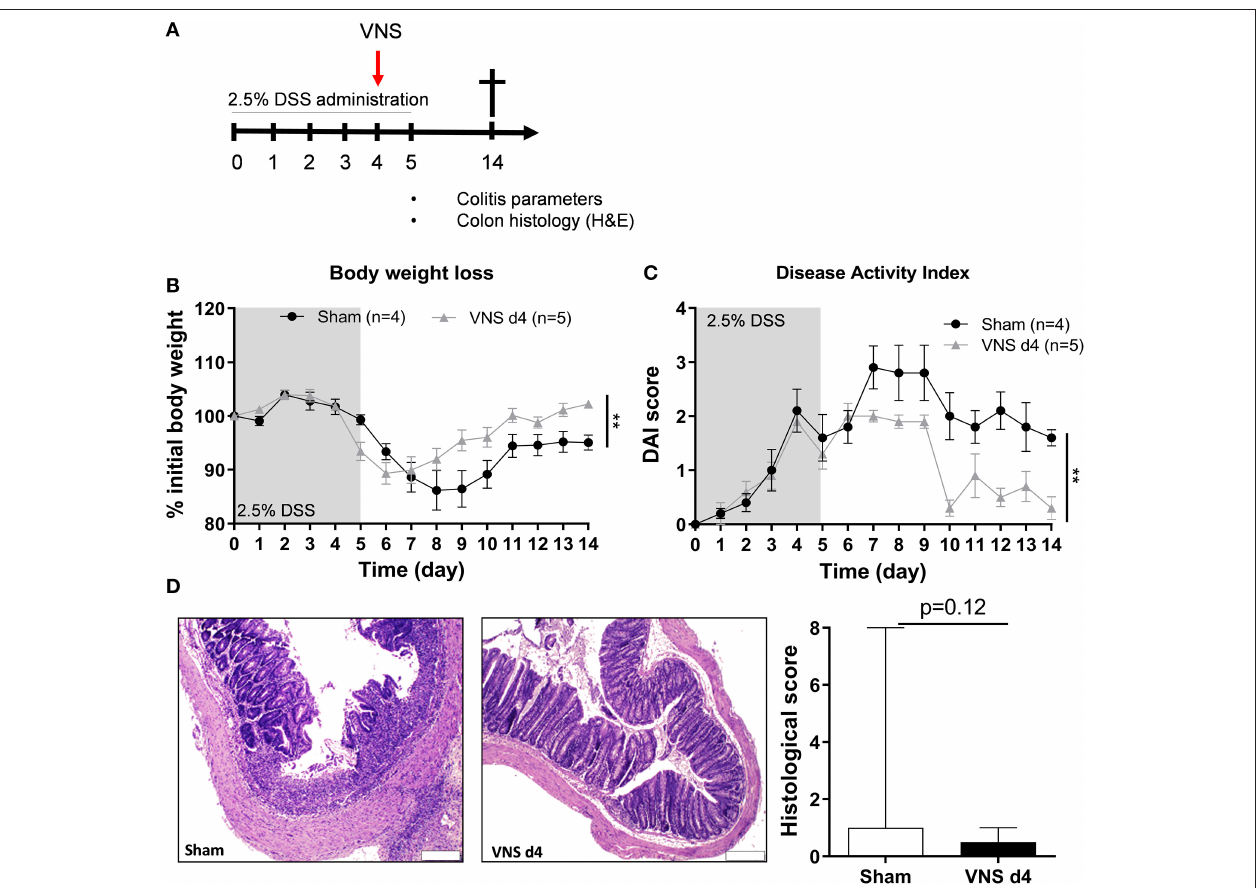
FIGURE 3 | Vagus nerve stimulation during DSS colitis improves body weight and disease activity. (A) Wild type mice were stimulated at day 4 and exposed to 2.5% DSS in the drinking water for 5 days, colitis severity was assessed daily. Mice were sacrificed at day 14 and tissue samples were collected for different analysis. Body weight (B) and disease activity index (C) were assessed daily. Data are expressed as mean ± SEM as determined by the repeated-measures two-way ANOVA test. ** p < 0.01; (sham-operated mice n = 4; VNS-treated mice n = 5). (D) Representative images of colonic sections stained with hematoxylin and eosin (H&E) from sham- and VNS-stimulated mice. Scale bars are 200 µ m. Bar graphs represent histological injury score of colonic samples of sham- and VNS-treated mice 14 days post colitis induction. Data are expressed as median ± interquartile range as determined by the Mann- Whitney test (sham-operated mice n = 10; VNS-treated mice n = 7). (A–D) shows representative experiment with at least 1 similar